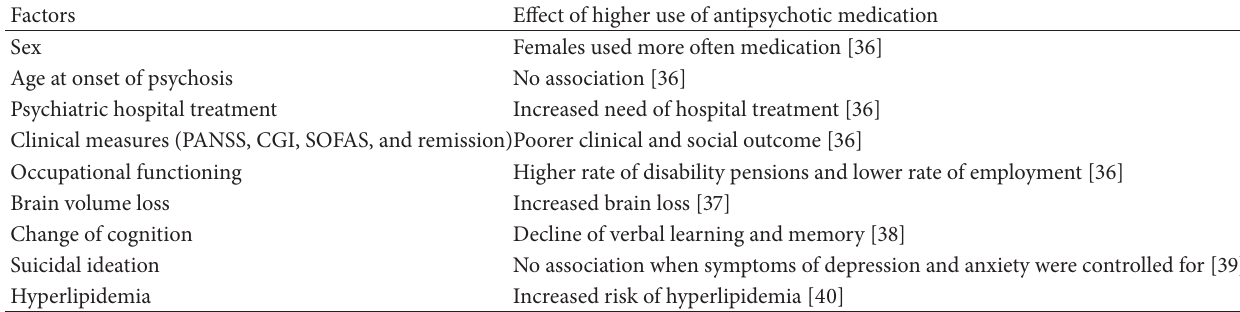
Table 3: Factors associated with the use of antipsychotic medication in the Northern Finland Birth Cohort 1966.